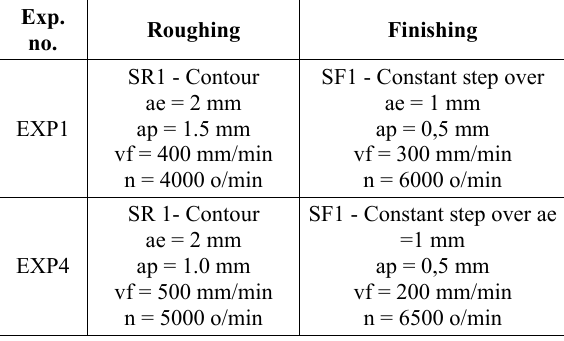
Table 3. Roughing and finishing strategies and cutting parameters in the second phase